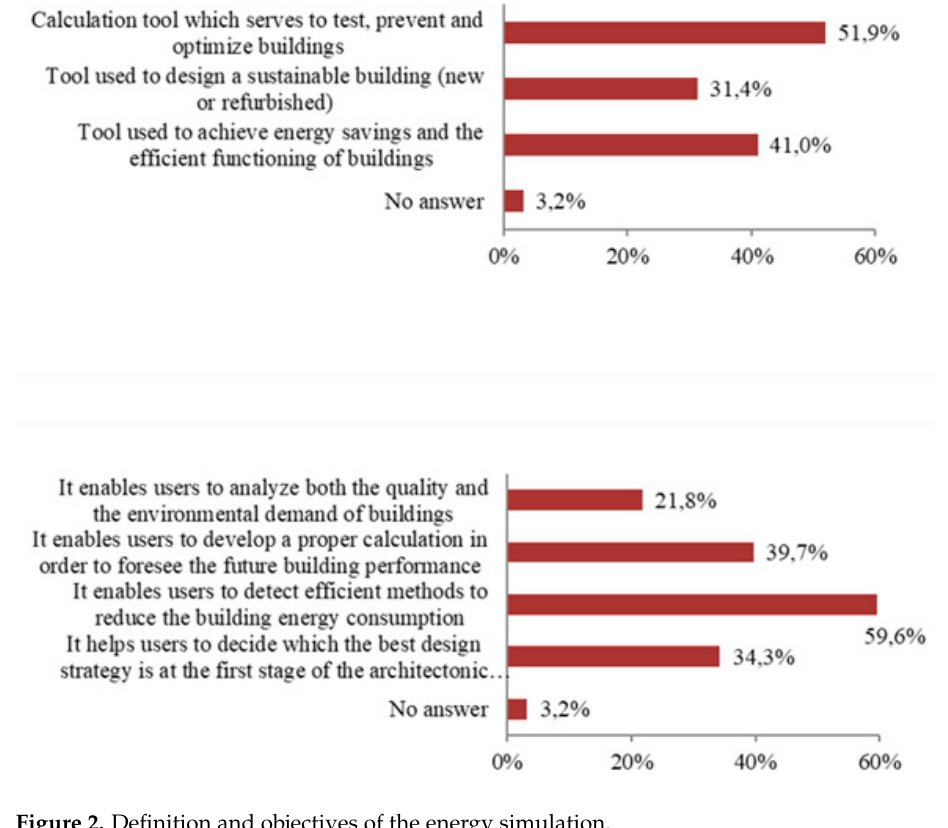
Figure 2. Definition and objectives of the energy simulation.